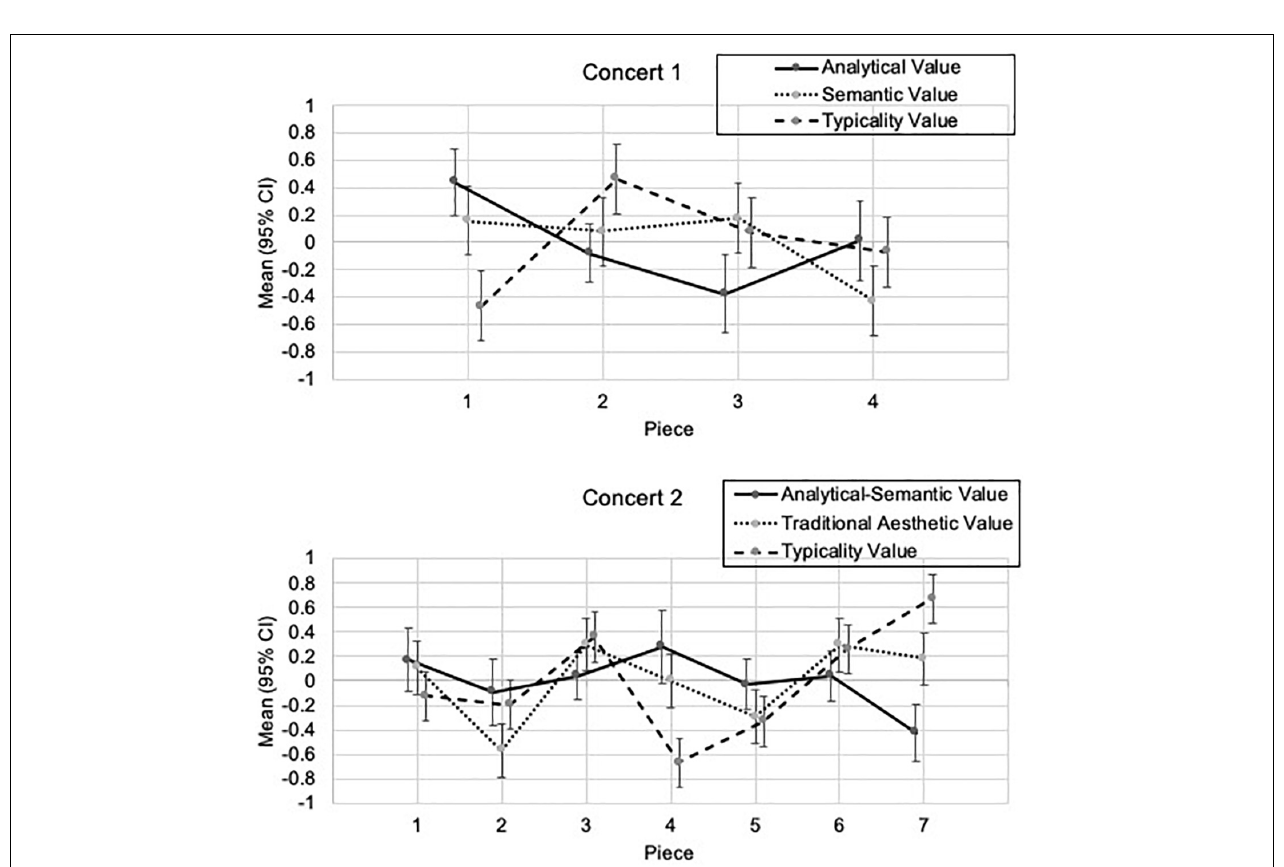
FIGURE 2 | Predicted mean aesthetic judgment factor values separated by piece, concert, and value